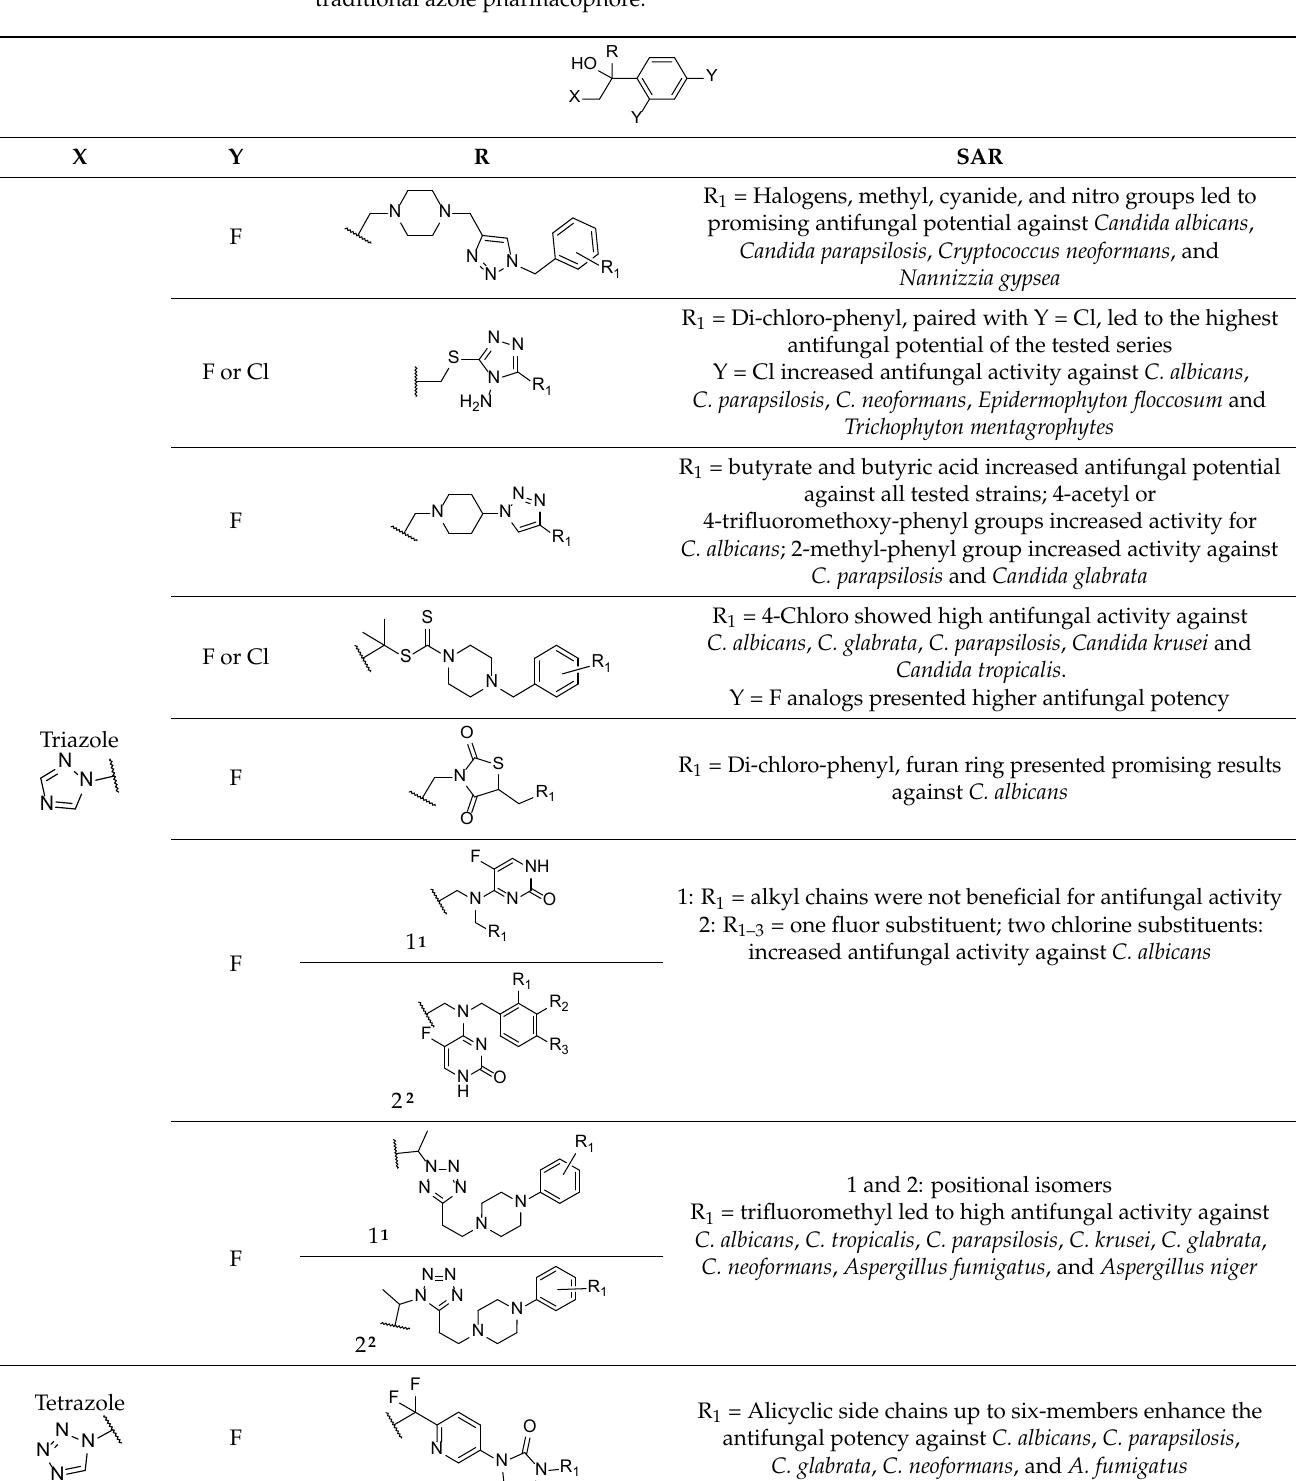
Figure 23. Chemical structures of compounds 41 and 42 , and SAR [103].